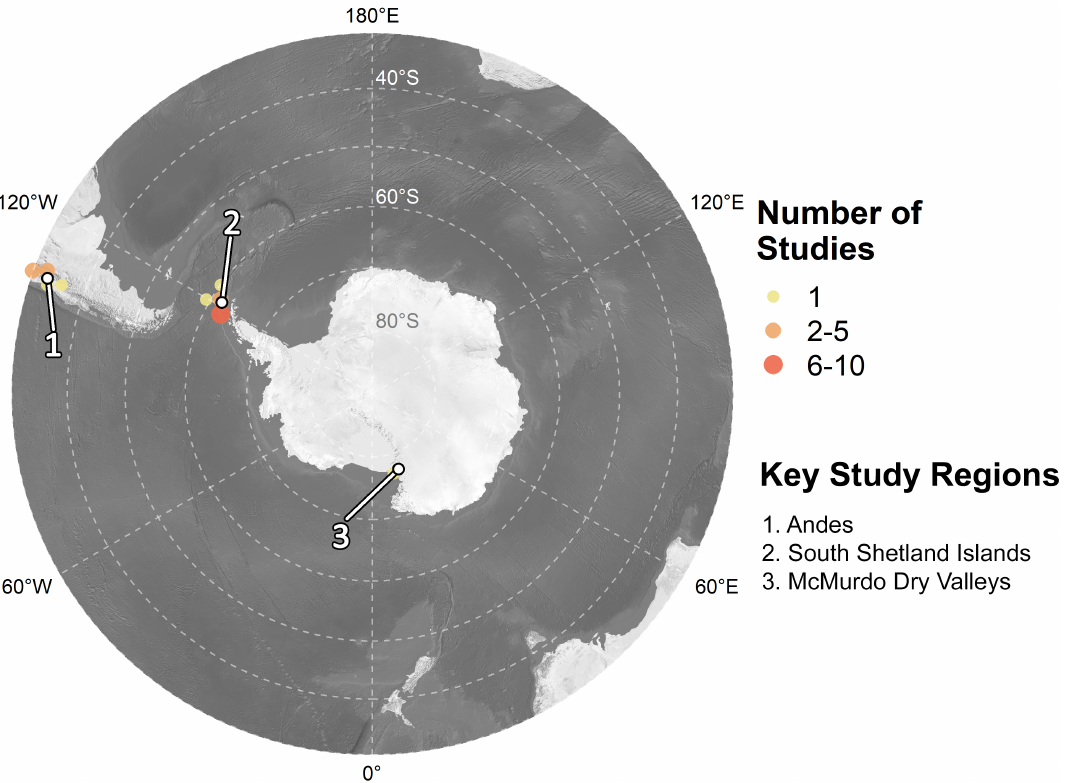
Figure 6. The study area distribution of the reviewed articles for the Southern Hemisphere. One study may have several study areas. A shaded relief by Natural Earth [203] was utilized as a background map. All data is visualized in a polar Lambert azimuthal equal area projection. Circum-Antarctic studies were excluded from this visualization. Three key regions with study clusters are marked and